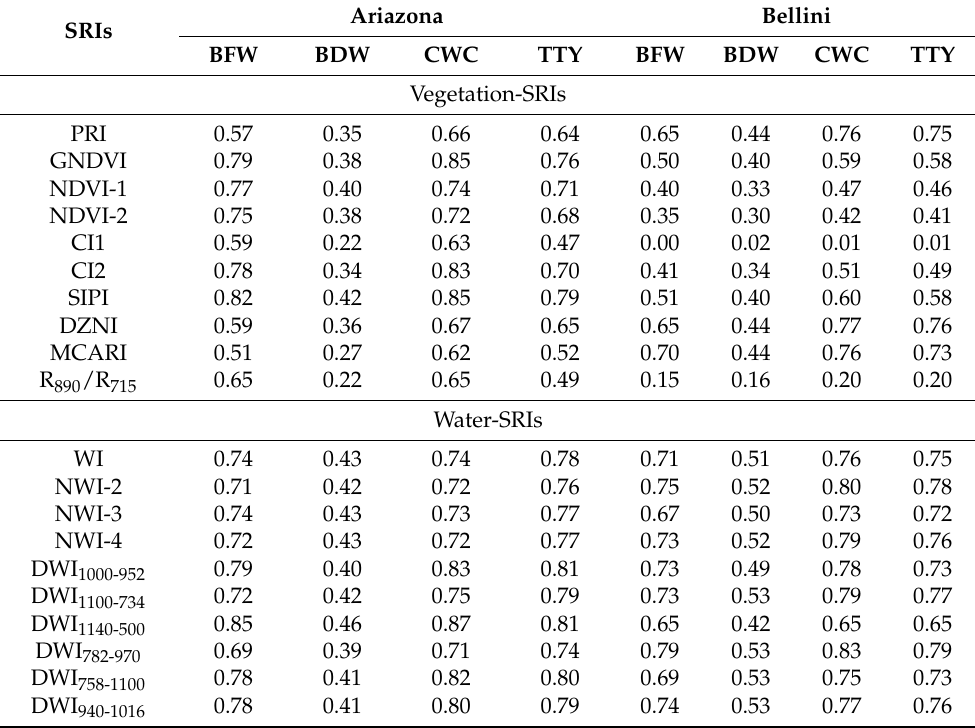
Table 4. Determination coefficients of the relationship between different SRIs and biomass fresh weight (BFW), biomass dry weight (BDW) canopy water content (CWC), and total tuber yield (TTY) of two potato varieties subjected to different irrigation regimes across two years ( n =